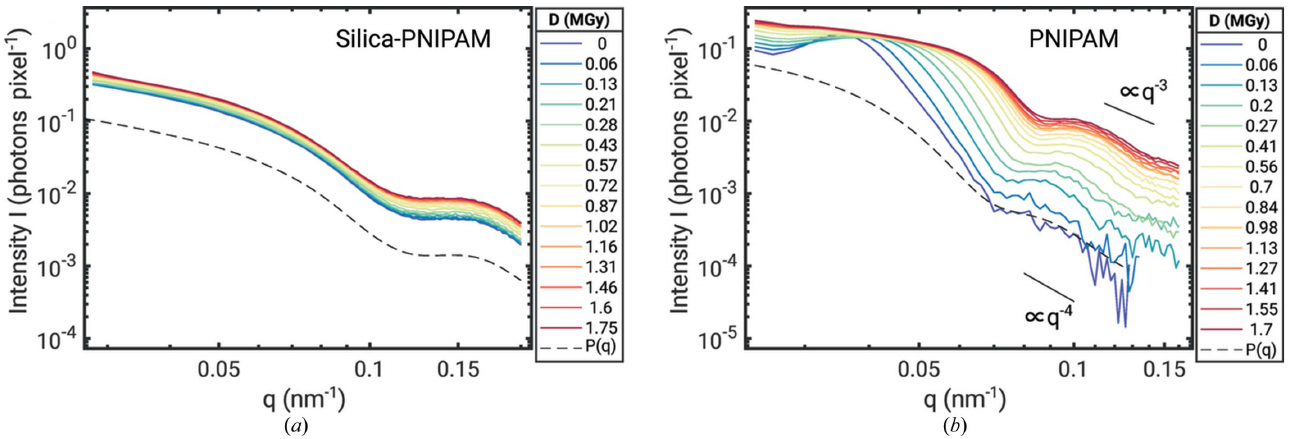
Figure 2 Azimuthally integrated intensity I ð q Þ per shot from both samples for various doses: ( a ) silica-PNIPAM core-shell system. The dashed line (offset for clarity) corresponds to a form factor of a core-shell system consisting of 41 nm core radius of silica particles and 40 (cid:5) 2 nm thick PNIPAM shell. ( b ) PNIPAM nanogel. The dashed line corresponds to a form factor of spheres with 60.5 nm radius.